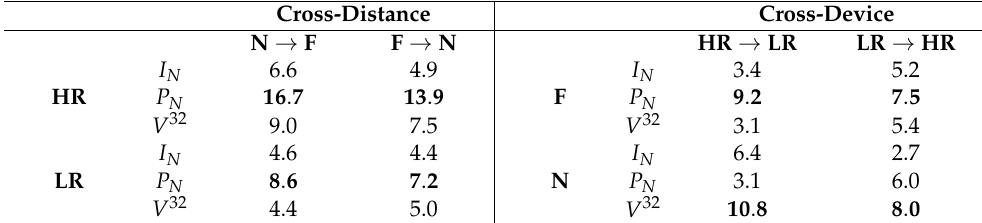
Table 7. Results on MultiSFace, in terms of recognition accuracy. Tests are carried using different gallery and probe data. In the left part, cross-distance tests ( N ear and F ar distance) are reported keeping the sensor fixed. In the right part, cross-device tests ( HR and LR , i.e., high and low resolution) are reported keeping the distance